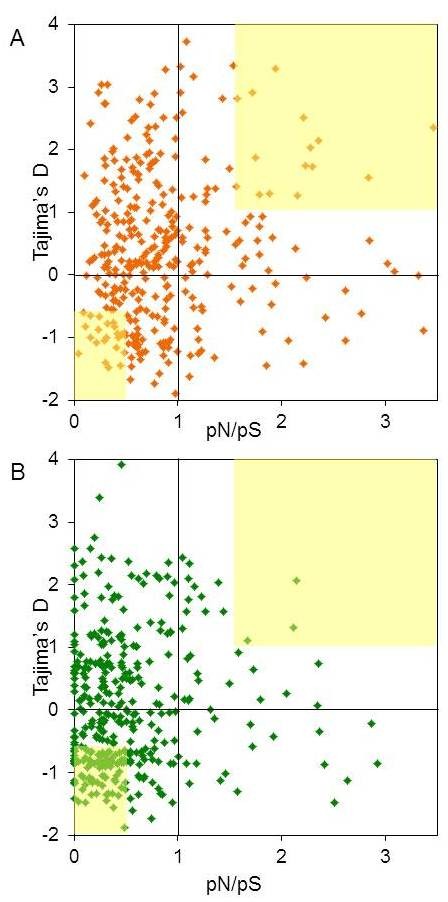
Selection signatures in the OR genes. Correlation of non-synonymous to synonymous substitution rate (pN/pS) with Tajima’s D values for A, 364 intact OR genes and B, 439 single coding exon genes. Data are plotted for the European population, other populations in Additional file 1: Figure S4. The difference between the ORs and the control genes was tested using the Kolmogorov-Smirnov test yielding p = 1.936*10-24 for pN/pS, and p =2.26*10-5 for Tajima’s D. The yellow squares highlight regions which might act under non-neutral selection, top right with D>1, pN/pS>1.5 (balancing selection), and bottom left with Tajima’s D<−0.5 and pN/pS<0.5 (purifying selection). Additional file 1: Table S3 lists the 57 ORs found under purifying selection in all populations.